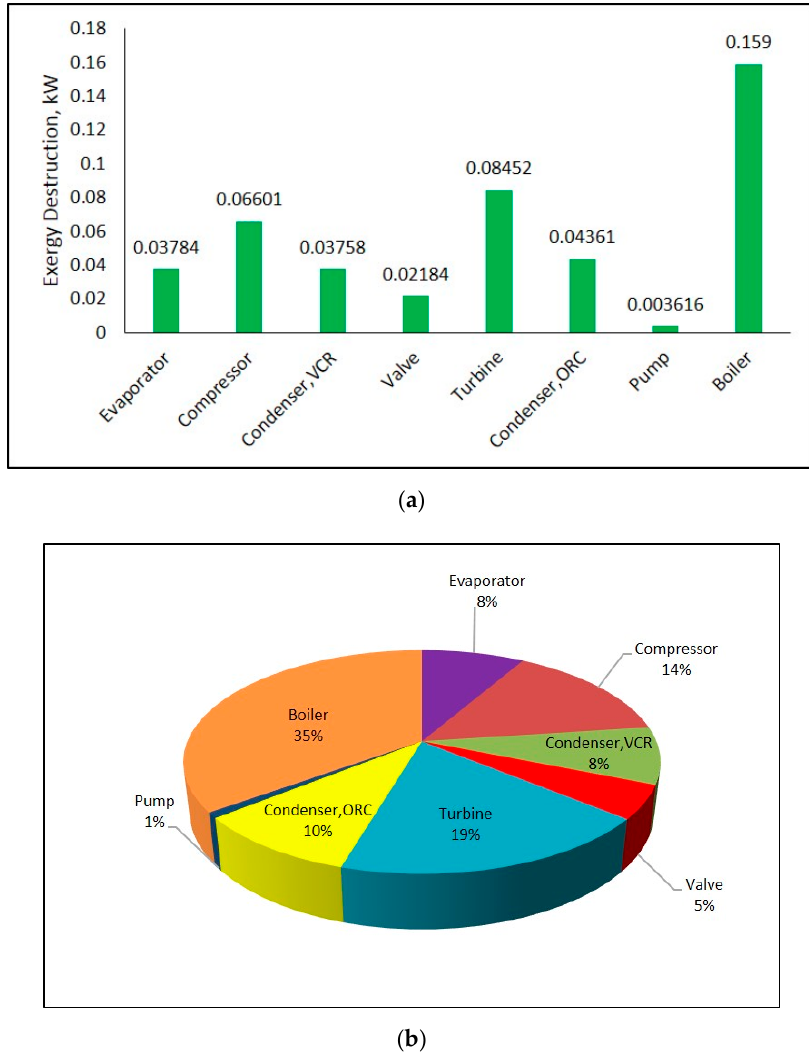
Figure 11. Exergy destruction rate ( a ) and exergy destruction ratio ( b ) of components in combined ORC-single evaporator VCR cycle.